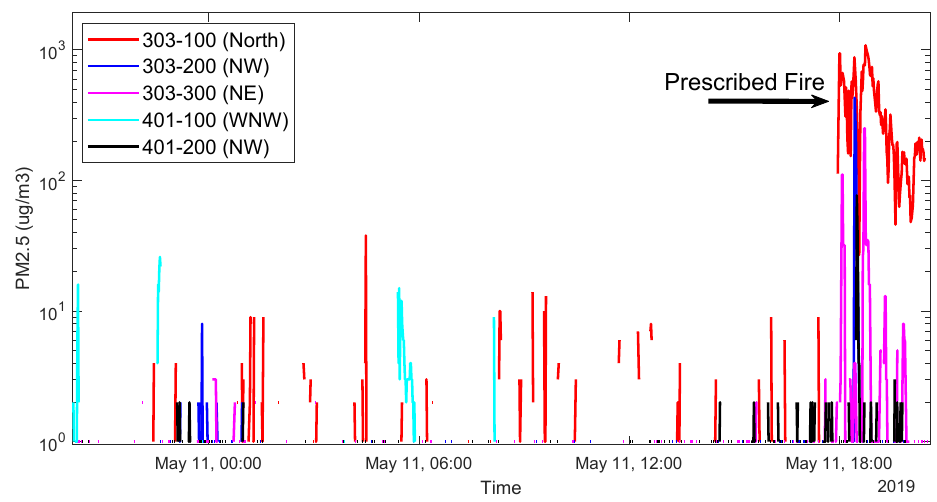
Figure 3. PM 2.5 background concentrations before prescribed fire. Enhancements on the far right indicates the time of fire.